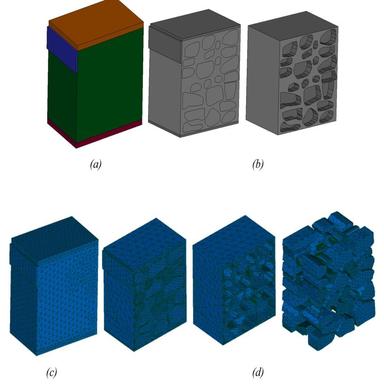
Macro- (a,c), and micro- modelling (b,d) geometries and mesh representation with the presence of steel plates.